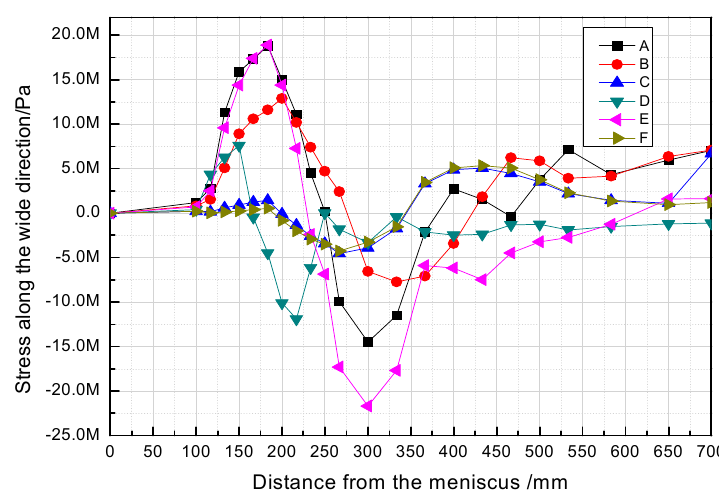
Figure 9. Stress along X direction with distance at some typical points .